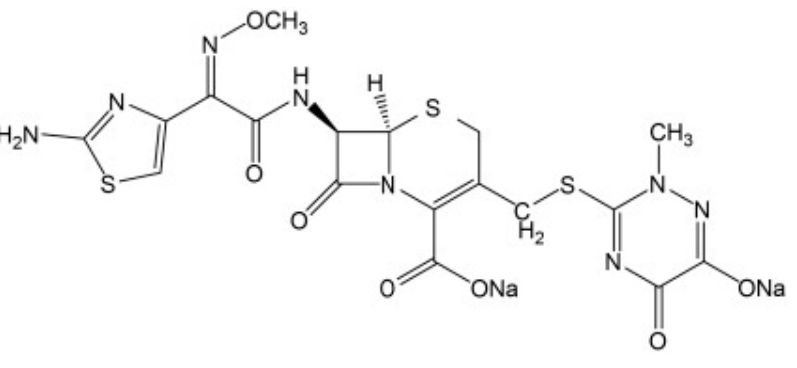
Figure 1. Chemical structure of ceftriaxone [17].